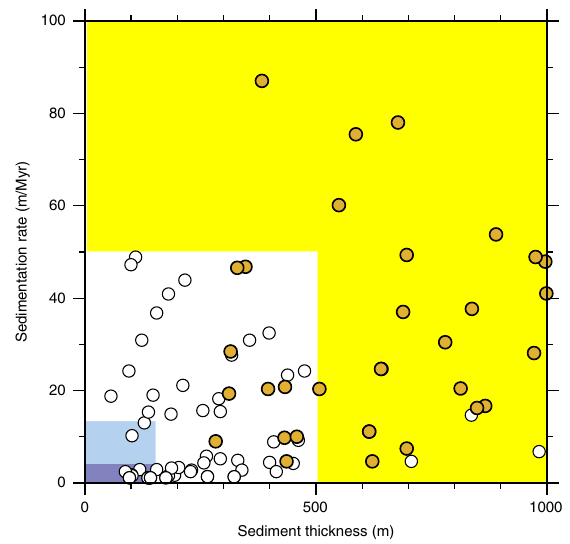
Fig. 5 Plot of sediment thickness and sedimentation rate at ODP and IODP sites. Only sites where dissolved SO 4 2 − has been measured in sedimentary porewater are shown. Orange dots indicate sites where SO 4 2 − concentrations go to zero within the upper 500 m of sediment. White dots indicate sites where SO 4 2 − is present from sea fl oor to basement. The yellow, dark blue and light blue fi elds identify the sediment thickness and sedimentation rate boundaries used to generate Fig. 1. The blue fi elds are based on previous results for dissolved O 2 reported by D ’ Hondt et al. 16 . Dissolved O 2 may or may not be present throughout the sediment at sites marked by white dots in the blue fi elds; no O 2 measurements were made at these sites. White dots in the yellow areas include sites where fl ow introduces SO 4 2 − through rubble or from beneath the sea fl oor and sites where SO 4 2 − diffuses upward from underlying brine. Orange dots in the white fi eld generally mark sites where dissolved chemical concentrations are not at diffusive steady state (e.g., because sedimentation rate has been unusually high in the recent geologic